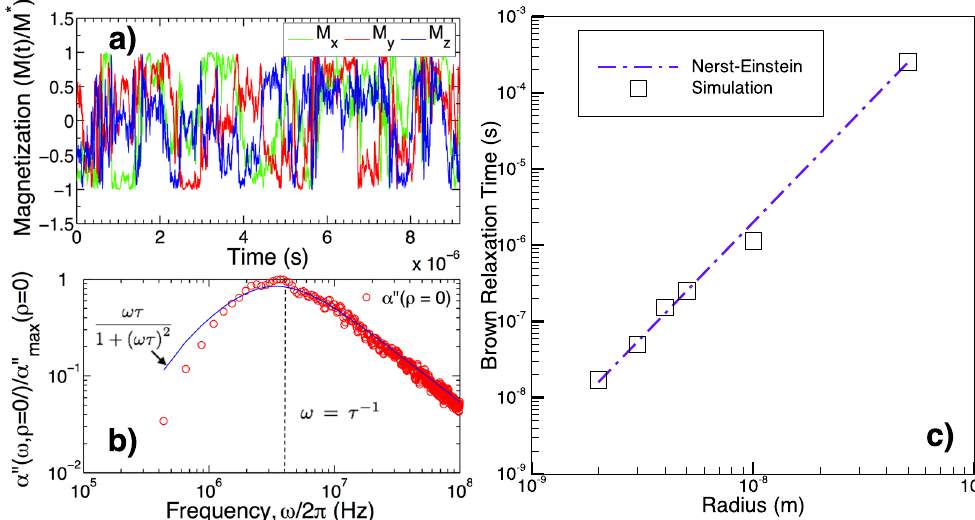
(cid:31)(cid:30)(cid:31) M t ( ) . M x / y and